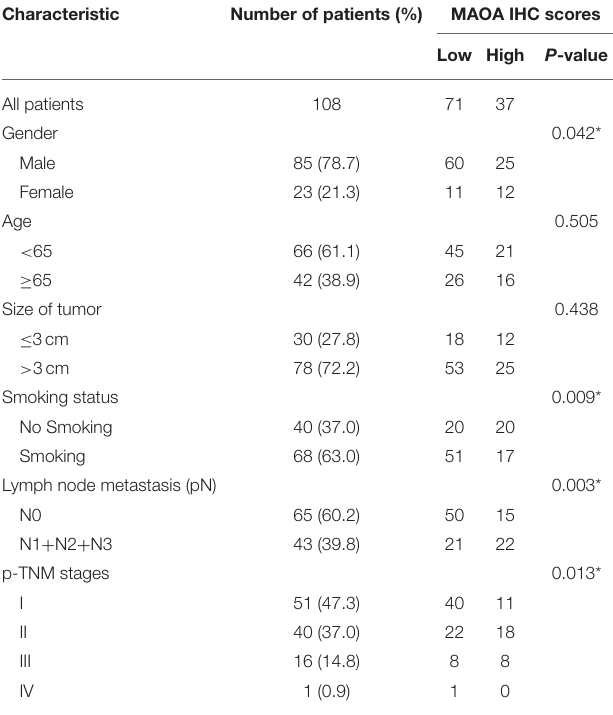
TABLE 1 | MAOA IHC scores and clinicopathological factors in LUAD patients. Characteristic